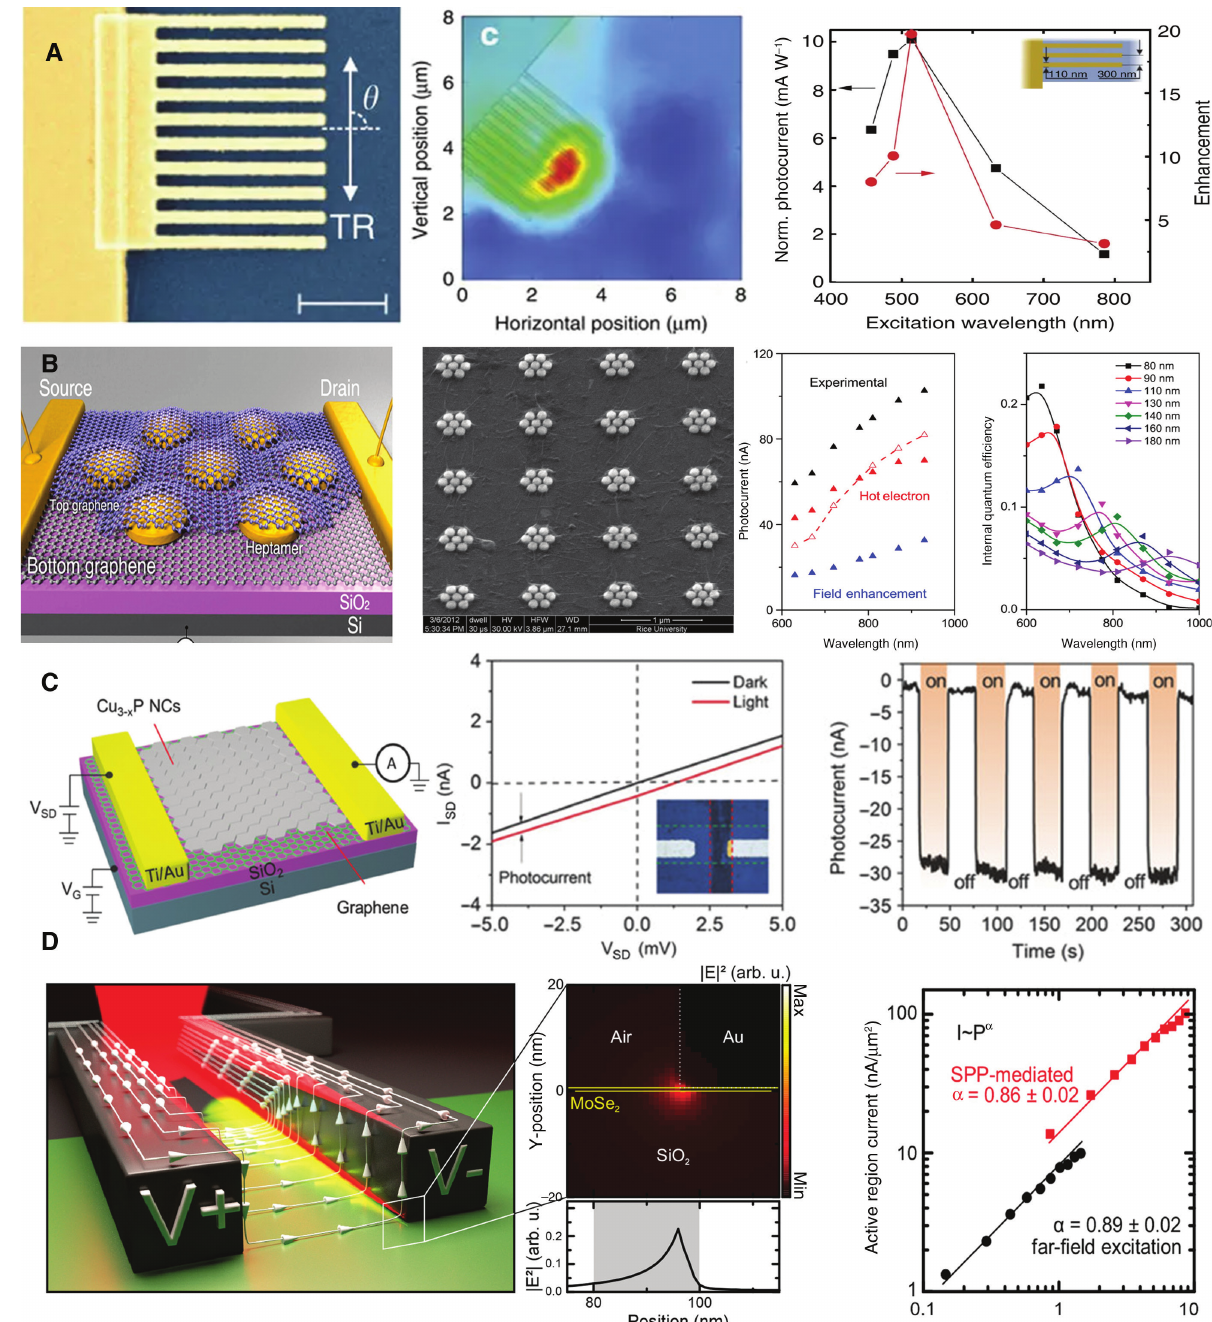
Figure 8: Two-dimensional materials plasmonic hybrid photodetectors with top illumination. (A) Interdigit metallic strip is deposited on top of the graphene to induce plasmonic enhancement. The finger width is 110-nm finger- width, and the pitch is 300 nm. The experiment data exhibit a 20-times higher photoresponsivity compared to the device without metallic nanostructure. (B) Au heptamer is sandwiched between top layer graphene and bottom layer graphene to enhance photodetection effect. The measured data show an 800% enhancement of the photocurrent. (C) Graphene photodetector integrated with QDs. The I-V curve of the 405-nm incident light and the temporal response of 1550 nm is shown. (D) Plasmonic MoS photodetector with a subwavelength size 2 of detection region. The SPP-mediated responsivity is up to 18 mA/W, with the detection region of 0.03 μ m 2 . Reproduced/adapted with permission from Echtermeyer et al. (A), Fang et al. [214] (B), Sun et al. [215] (C), and Blauth et al. [216]